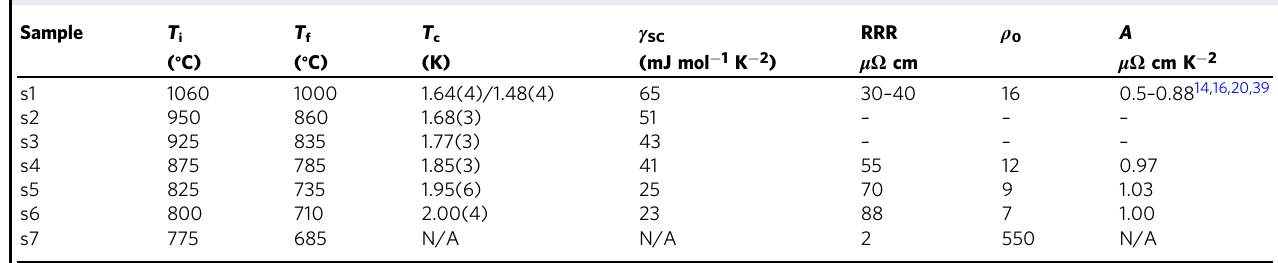
Table 1 Crystal growth parameters and physical properties of UTe 2 single crystals.